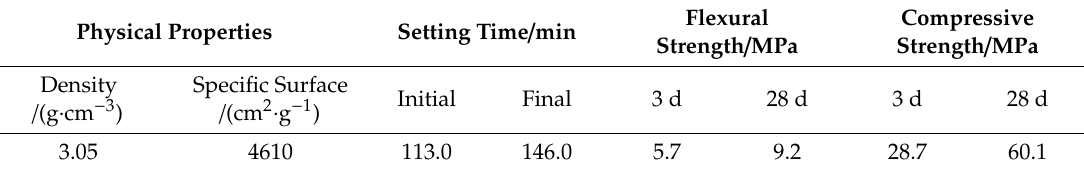
Table 1. Properties of cement.